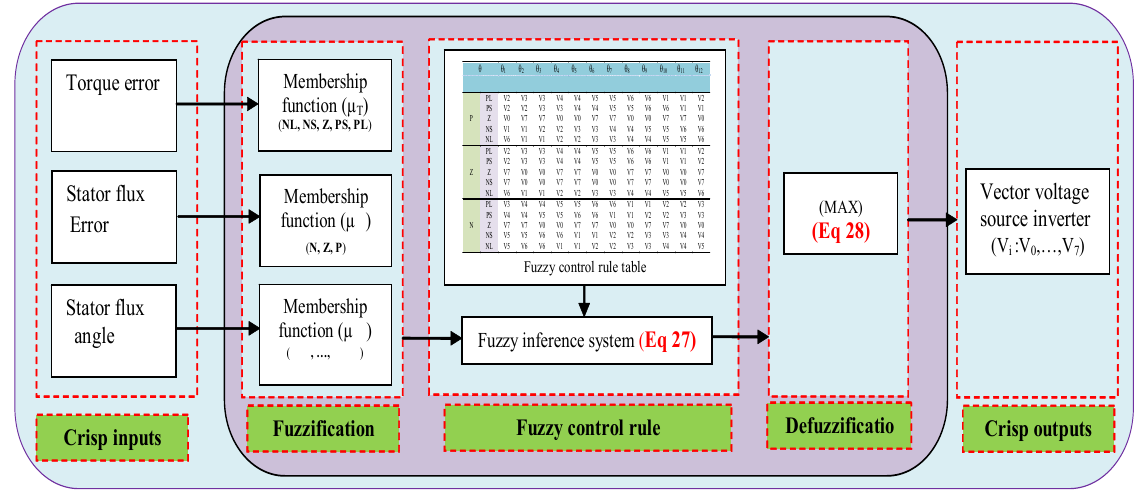
Figure 7. Principle of fuzzy logic system.